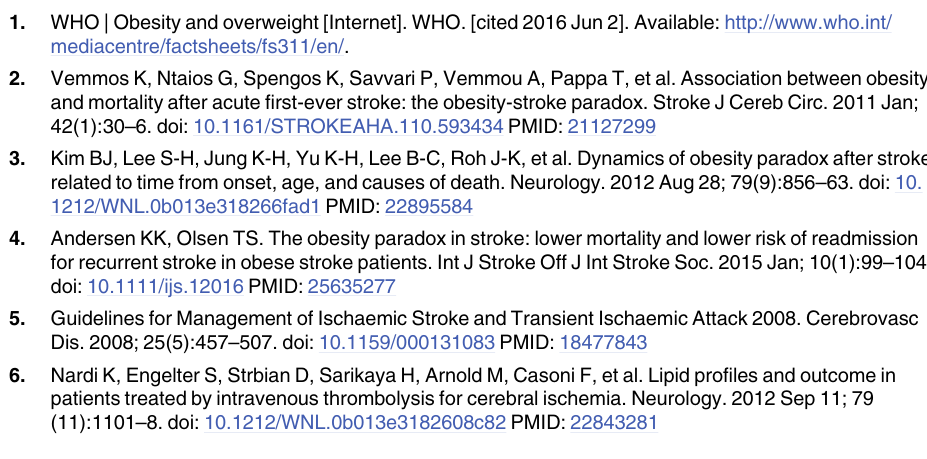
S2 Table. Patient numbers and study periods for each individual